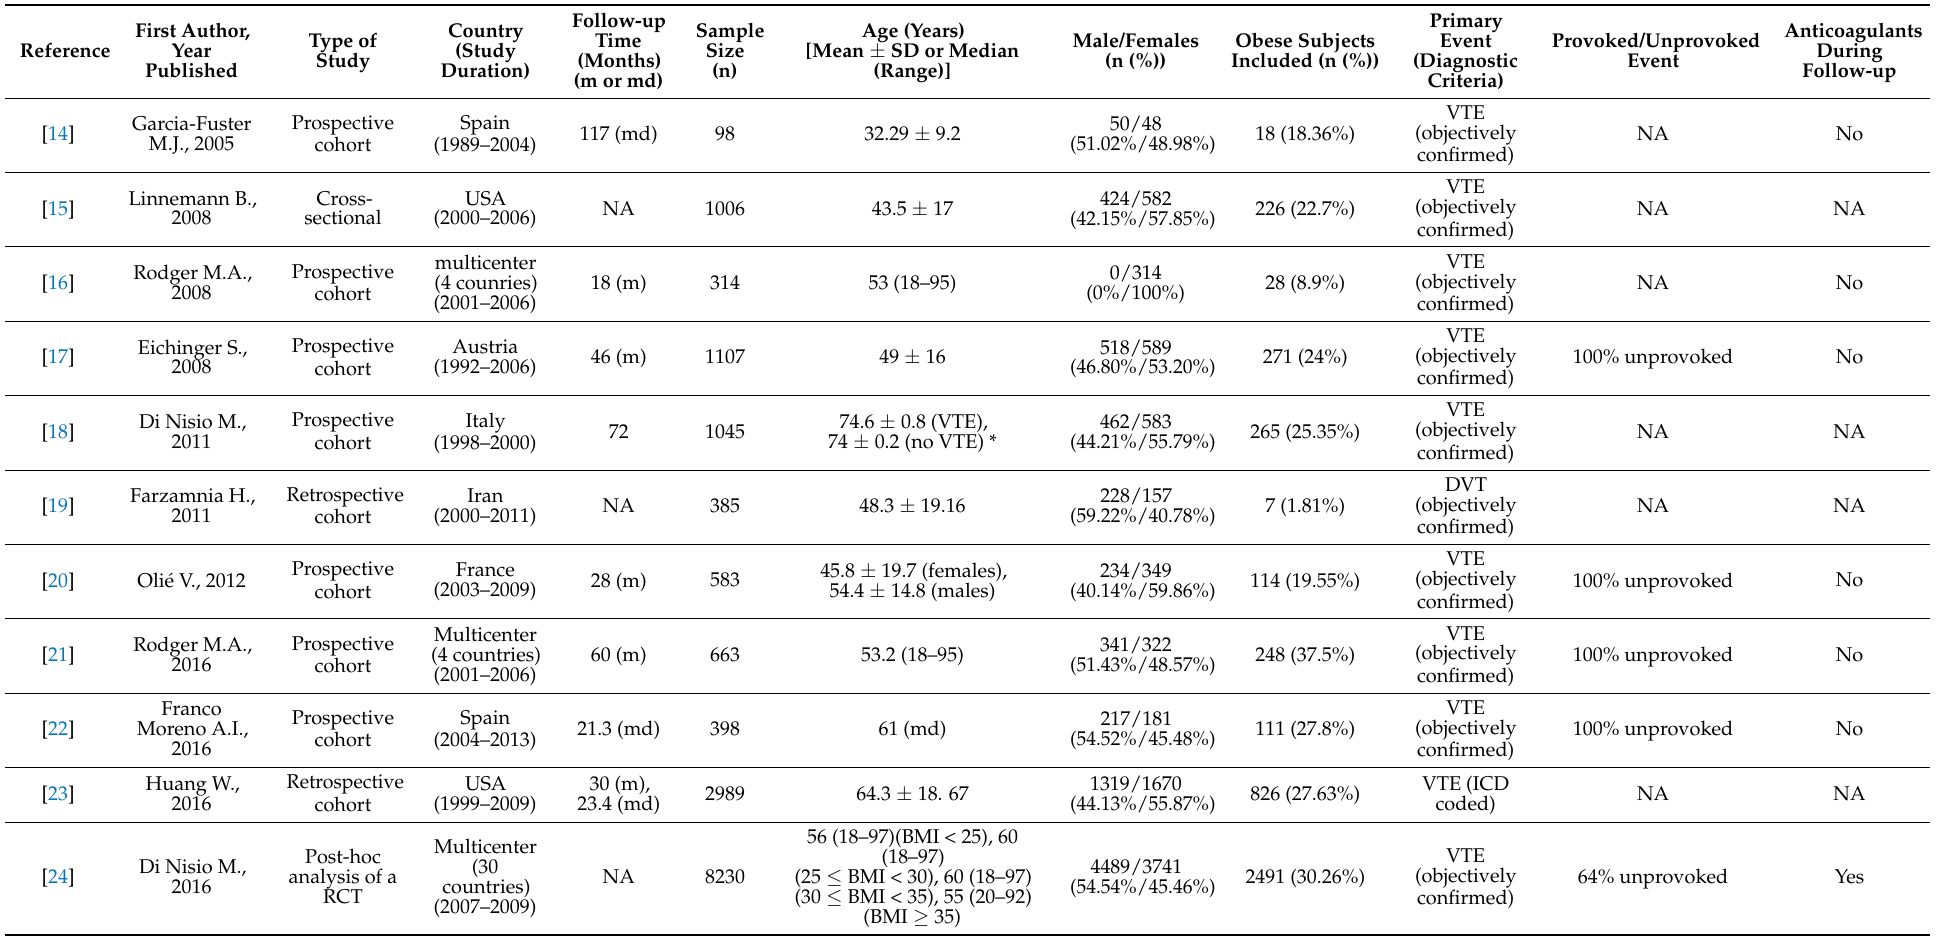
Table 1. The studies’ characteristics. Objectively confirmed VTE diagnosis (PE or DVT) was based on clinical and imaging data. “Anticoagulants during follow-up” column refers to whether the subjects enrolled in the study were receiving anticoagulants when the recurrence occurred after the first VTE event. Abbreviations: BMI (kg/m 2 ); VTE: Venous thromboembolic disease; DVT: deep venous thrombosis; PE, pulmonary embolism; m, mean; md, median, y, years; mo, months; n, absolute number; ICD, International Classification of Diseases; NA: Not available or not applicable., * Data are presented as mean ± SE, Data are presented as mean